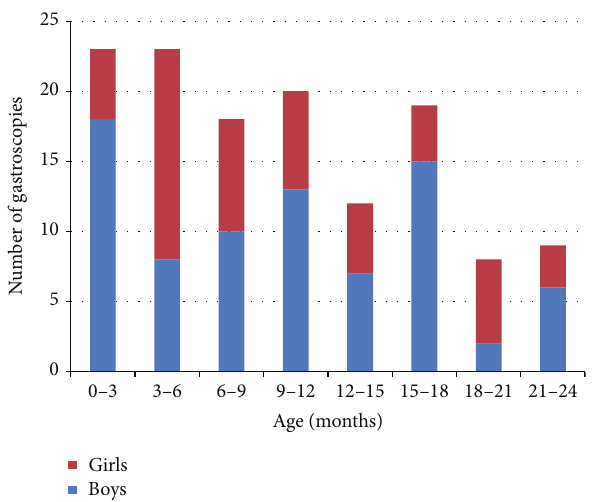
Figure 2: Age distribution across 132 gastroscopies performed on children under 2 years of age from July 2011 to May 2014.